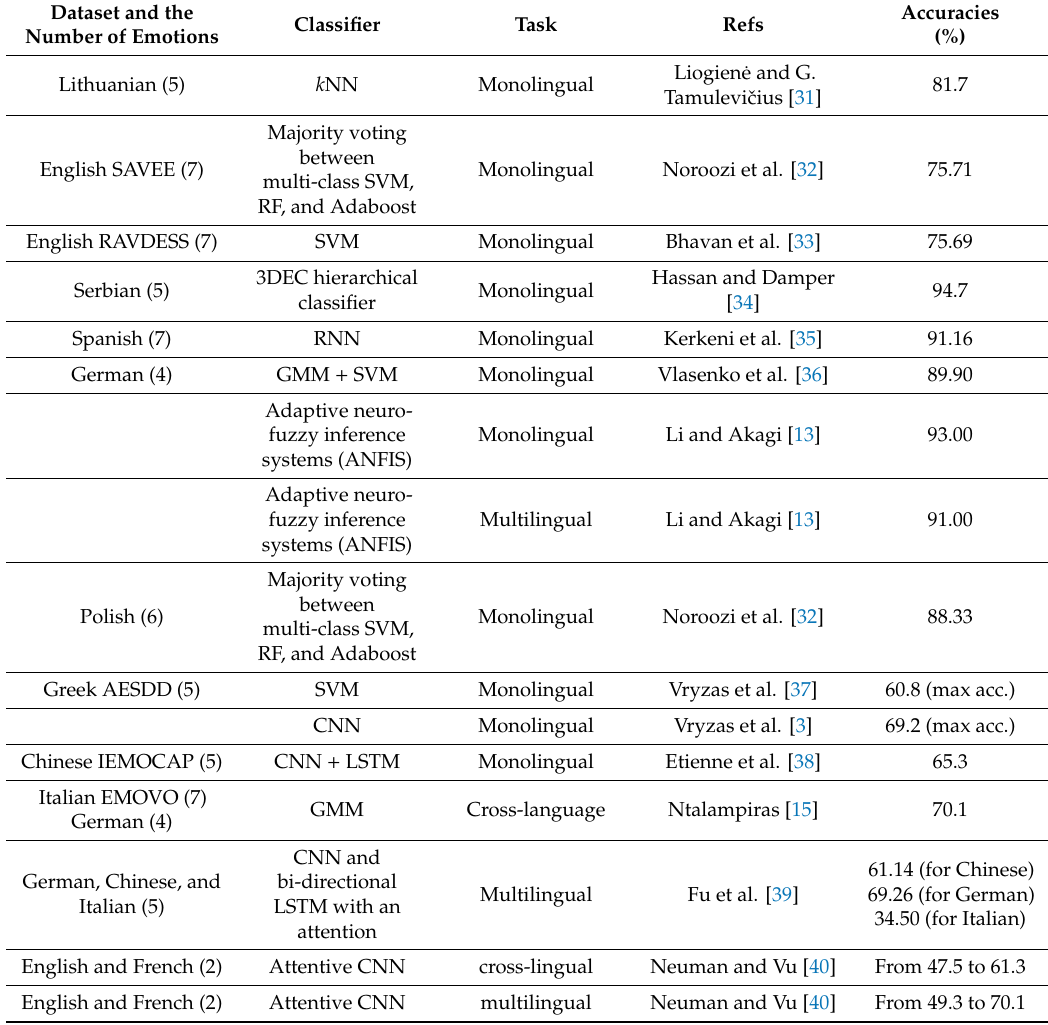
Examples of classification performance for the task of speech emotion recognition on datasets analyzed (CNN—convolutional neural network; k NN— k -nearest neighbor